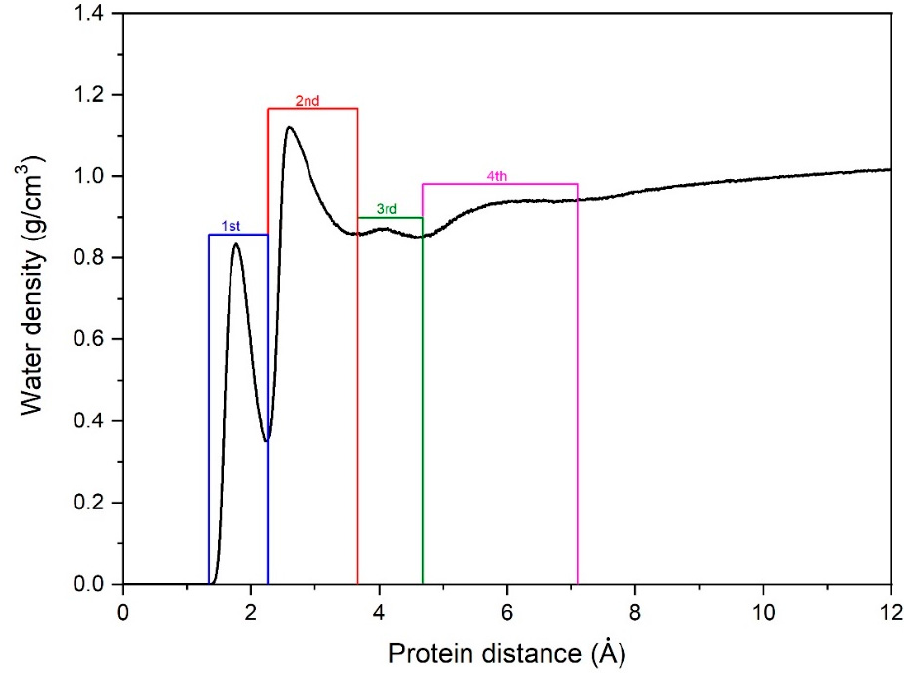
Figure 1. Radial density distribution of water molecules in the immediate environs of the ubiquitin surface. The four layers in closest proximity with the protein are marked in different colours.